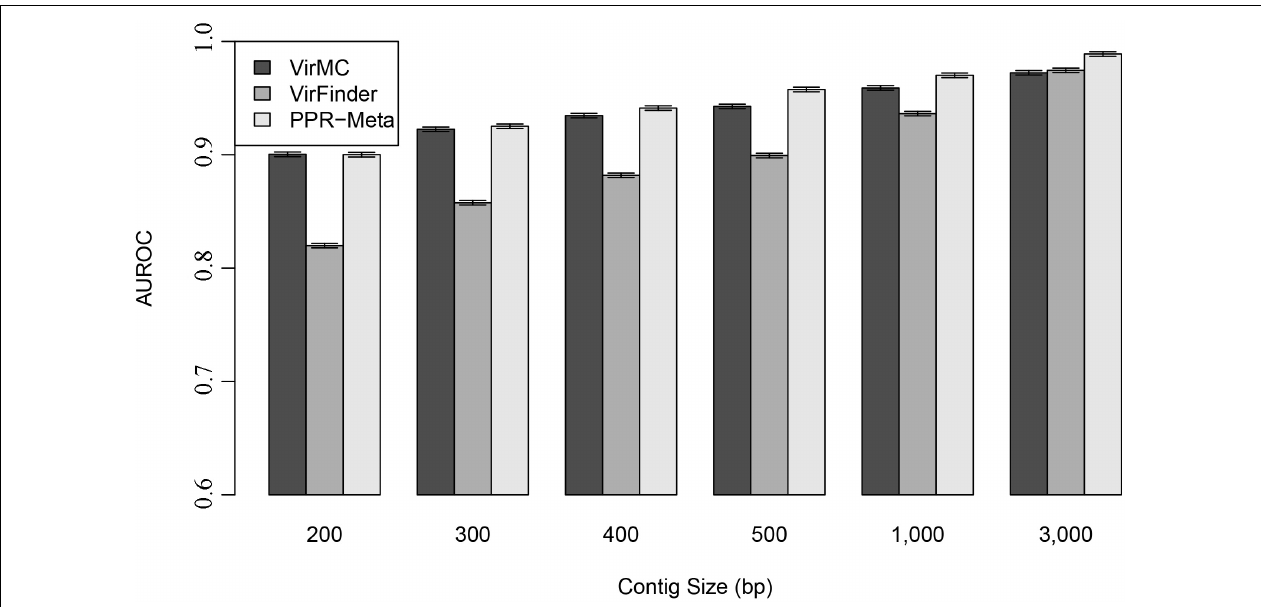
FIGURE 3 | Performance of VirMC, VirFinder, and PPR-Meta in predicting viruses for contigs with different lengths. The error bars depict standard errors determined from 30 bootstrap samples from the testing dataset. AUROC are shown when VirMC was trained using a Markov order of 9 and a cluster bin number of